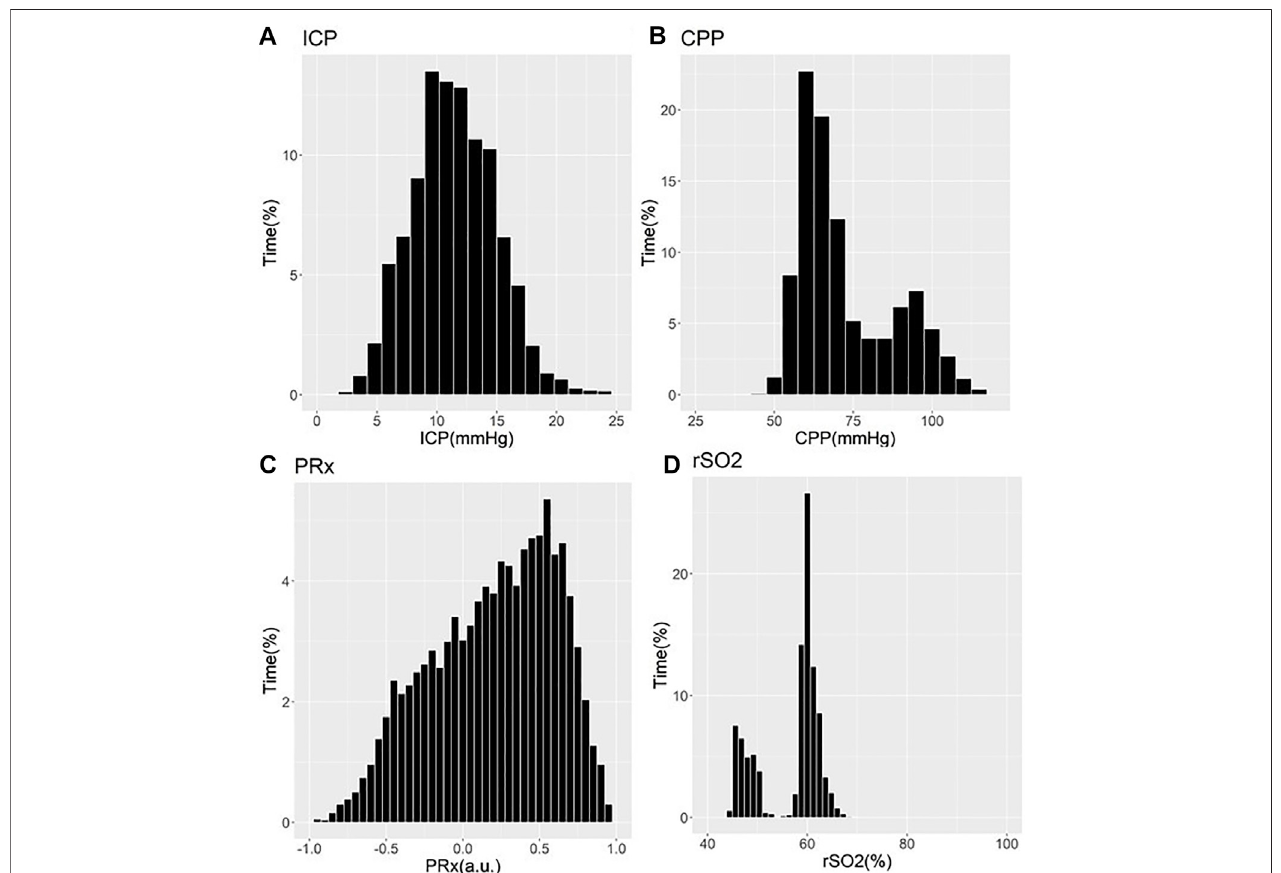
FIGURE 2 | Example of Cerebral Physiology in Severe TBI – 67 Year Old Patient – First 72 Hours of ICU Stay. a. u. (cid:1) arbitrary units, CPP (cid:1) cerebral perfusion pressure, ICP (cid:1) intracranial pressure, ICU (cid:1) intensive care unit, mmHg (cid:1) millimeters of Mercury, MAP (cid:1) mean arterial pressure, PRx (cid:1) pressure reactivity index (correlation between slow-wave of ICP and MAP), rSO 2 (cid:1) regional cerebral oxygen levels (Rt Frontal). Panel (A) (cid:1) histogram of ICP and % time of recorded physiology, Panel (B) (cid:1) histogram ofCPP and % time ofrecorded physiology, Panel (C) (cid:1) histogram ofPRx and %time ofrecorded physiology, Panel (D) (cid:1) histogram of rSO 2 and % time of recorded